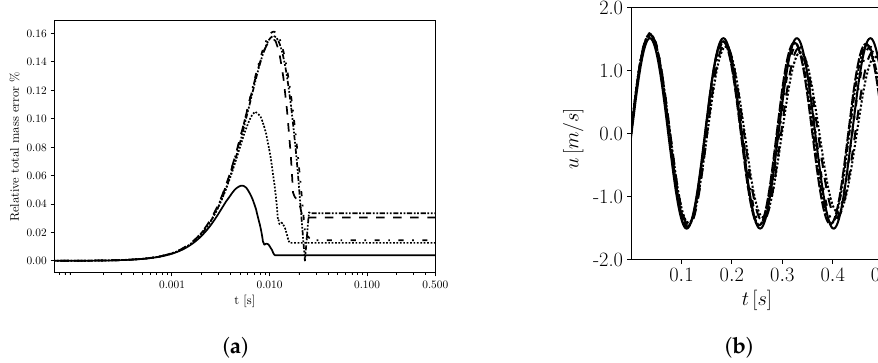
Figure 6. Oscillating water pipe: ( a ) evolution of the relative error ε tot ; ( b ) evolution of the velocity magnitude in the core region. Simulations were carried out at CFL max =0.1. Legend: